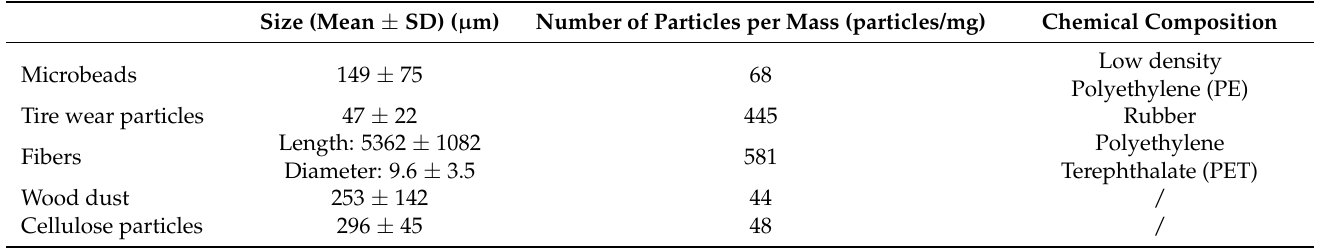
Table 1. Characteristics of microplastics (microbeads, tire wear particles, fibers) and natural particles (wood dust, cellulose particles).